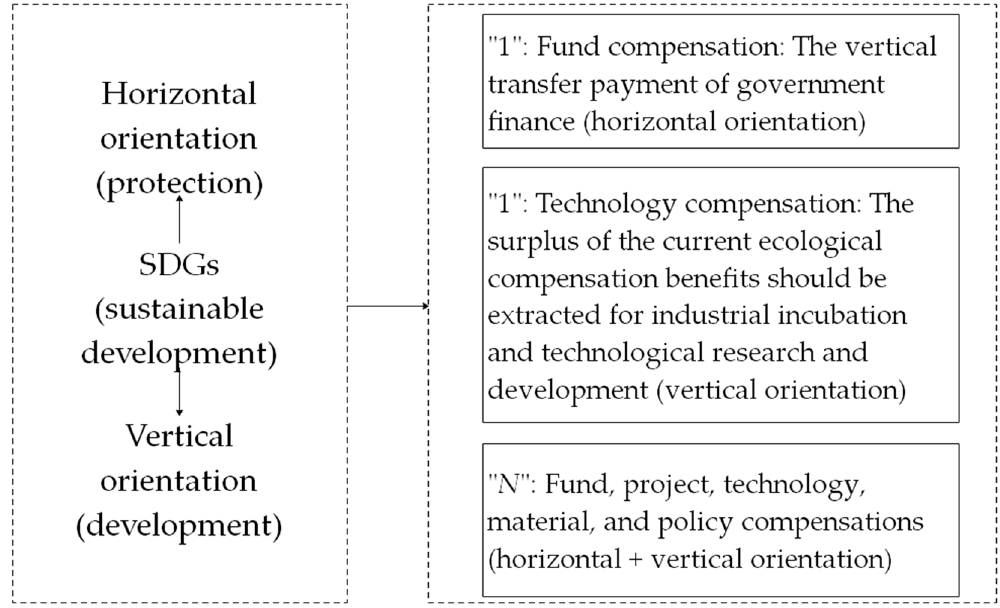
Figure 1. Sustainable development goals (SDG)-based ecological compensation system for basin-type national parks.